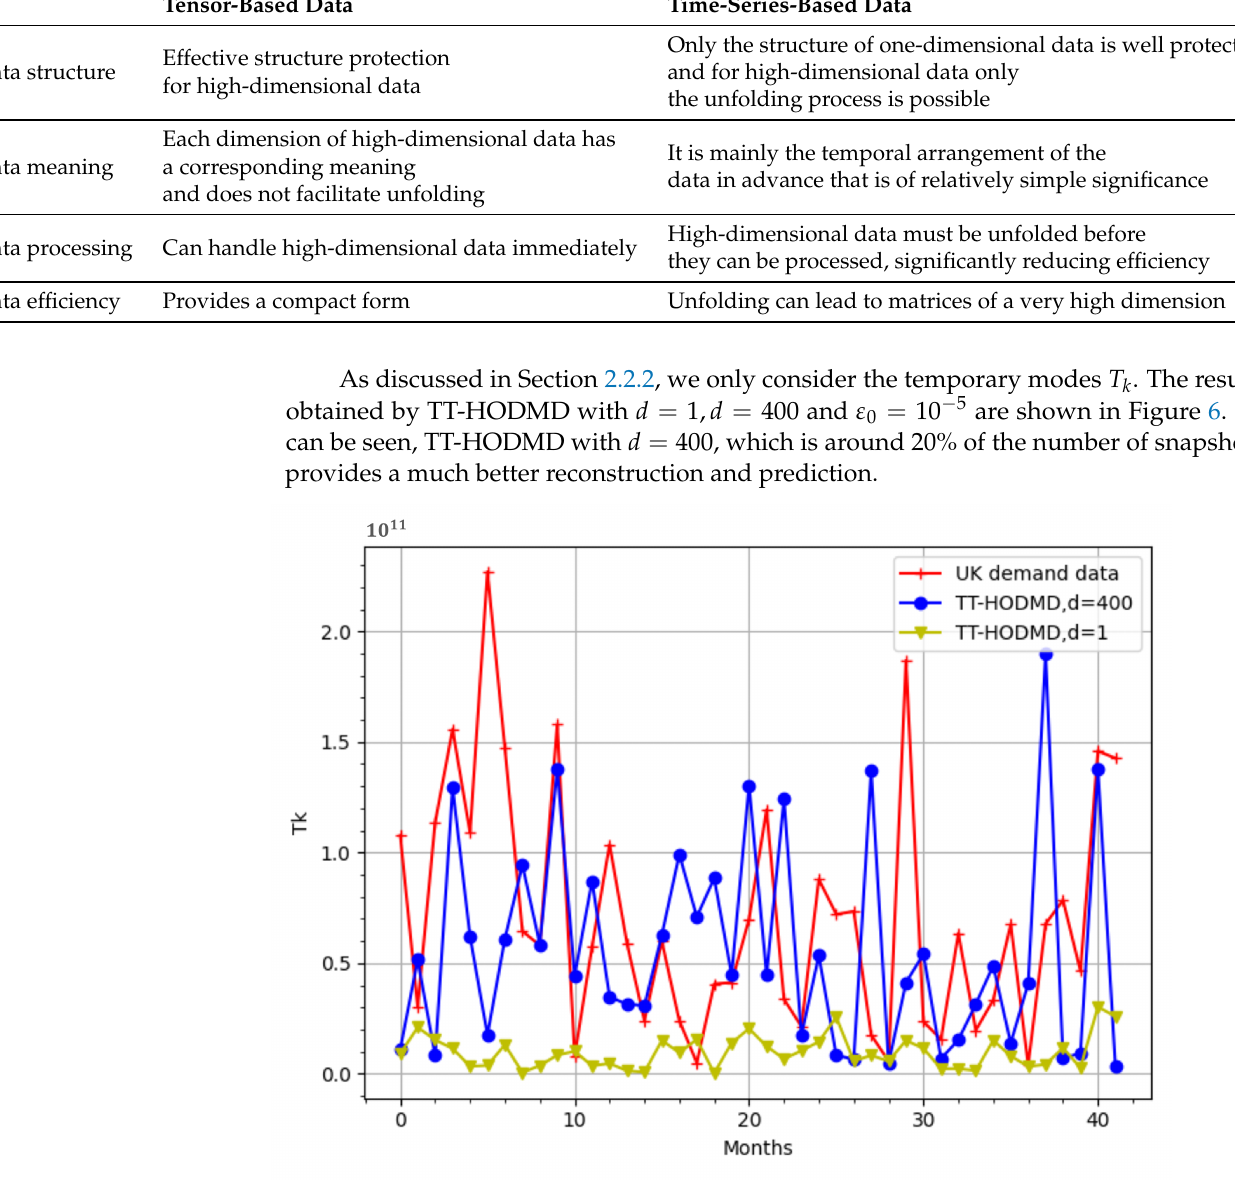
Figure 6. Comparison of TT-HODMD prediction with d = 1 and d = 400 against real UK demand